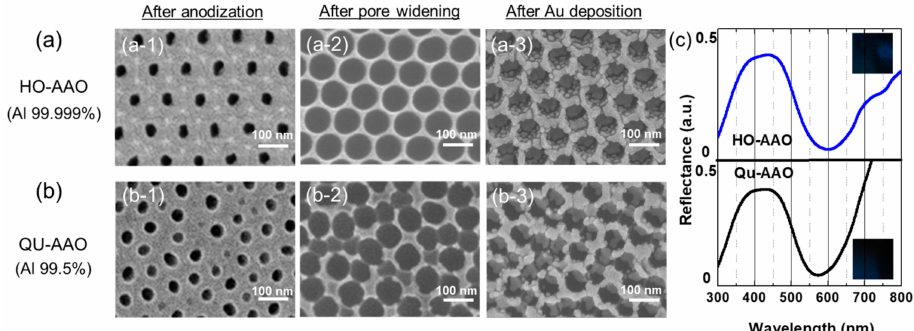
Figure 5. FE-SEM images and reflectance spectra of ( a ) HO-AAO and ( b ) QU-AAO based plasmonic nanostructures after pore widening process. ( a-1 ) and ( b-1 ) display nanopores after the final anodization process; ( a-2 ) and ( b-2 ) are FE-SEM images after the pore widening process for 70 min; ( a-3 ) and ( b-3 ) are images after gold deposition of 20 nm. The anodization times for QU-AAO and HO-AAO were 80 and 60 s, respectively. For all images, scale bar = 100 nm. ( c ) Reflectance spectra and camera images show almost identical optical properties between the